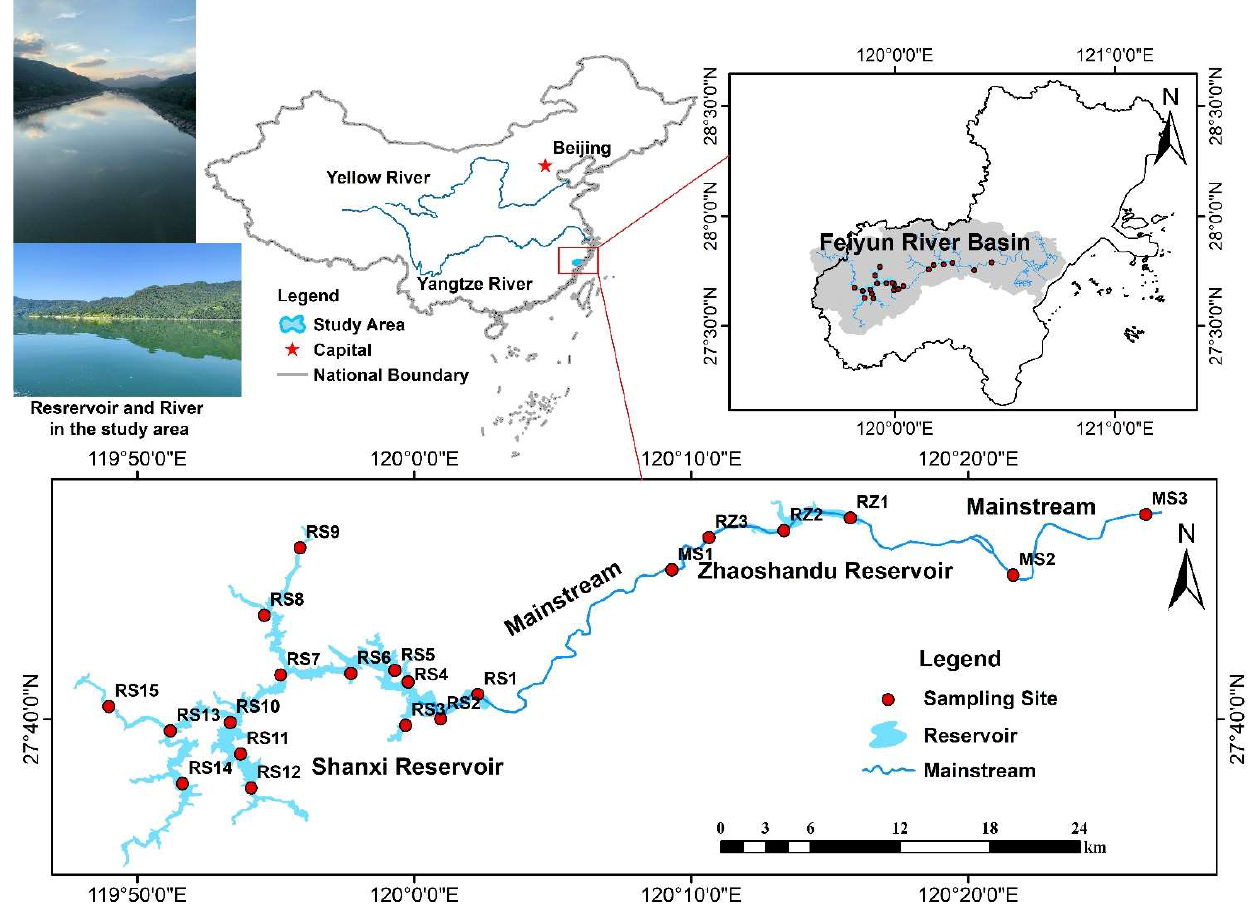
Figure 1. Location, rivers, and sampling sites of the Feiyun River Basin,